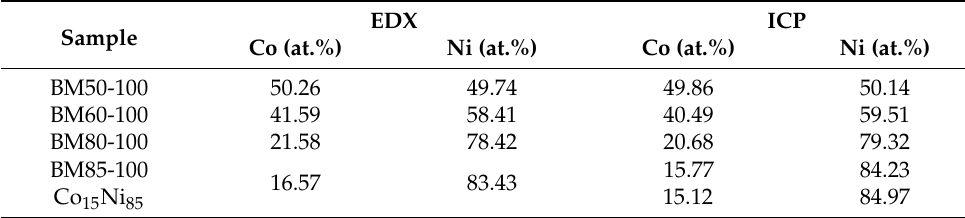
Table 2. Atomic percentages (at.%) of Co and Ni for Co 100 − x Ni x (x ≥ 50) NPs. EDX ICP Sample Co (at.%) Ni